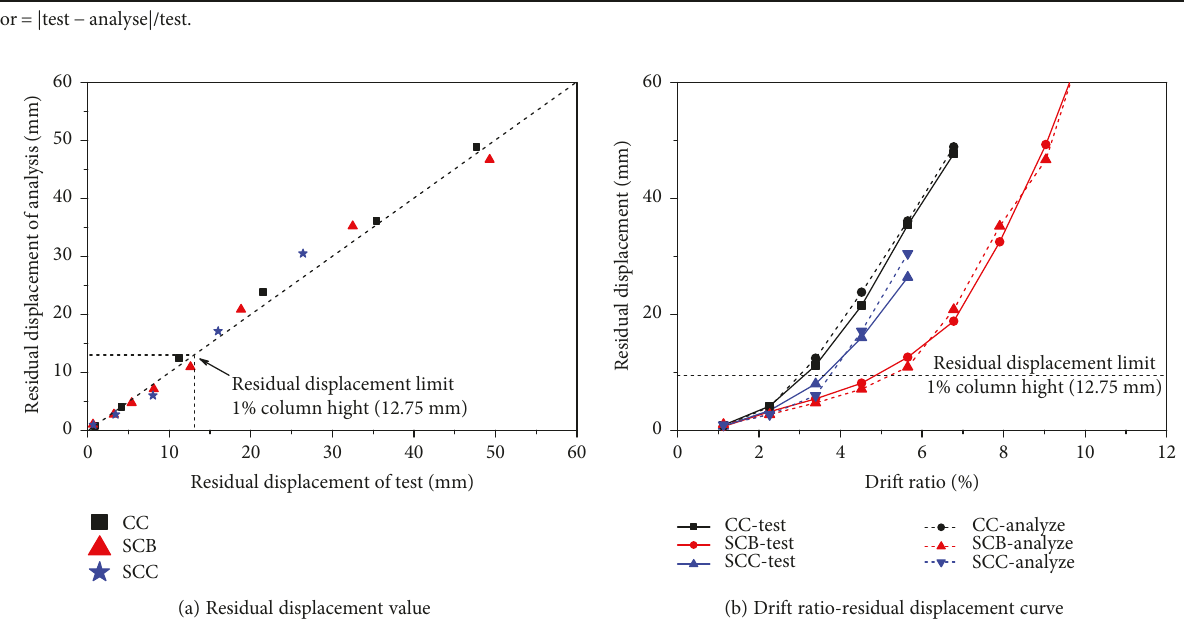
Figure 8: Comparison between modeling and test results on residual displacement. Table 5: Parameter value